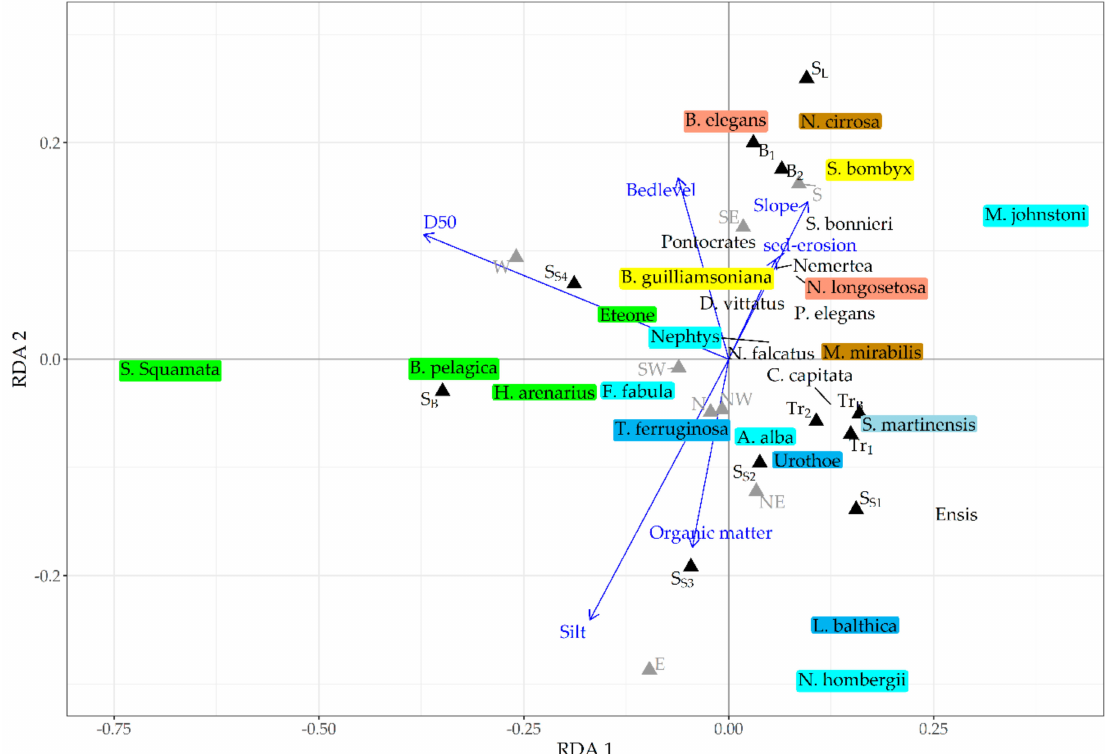
Figure 8. Ordination diagram first two-axis pRDA analysis based on the transformed abundance data with the environmental parameters conditioned for the spatial and temporal variation and the average bed profile. Parameters with continuous values (D50, bedlevel, Slope, SE, OM, and mud) are given as arrows. Parameters described as a factor are given with triangles (black = morphological features, grey = aspect). Key species per morphological feature are indicated with a color (Green = S B , brown = S L , yellow = B 2 , light blue = S S1 , sky blue = S S3 , cyan = S S4